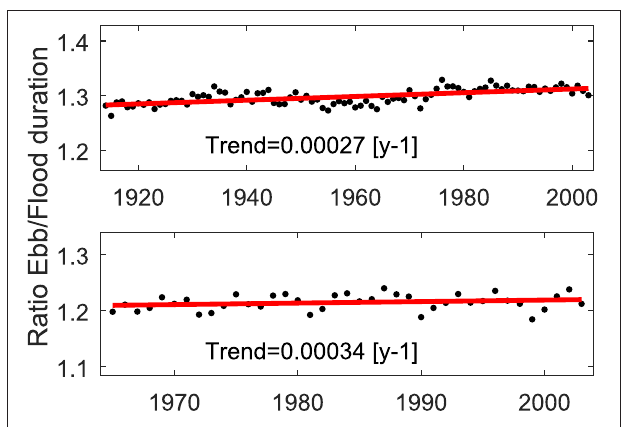
FIGURE 5 | Ratio of the annual mean ebb and flood duration of Buenos Aires (Upper) and Mar del Plata (Lower)